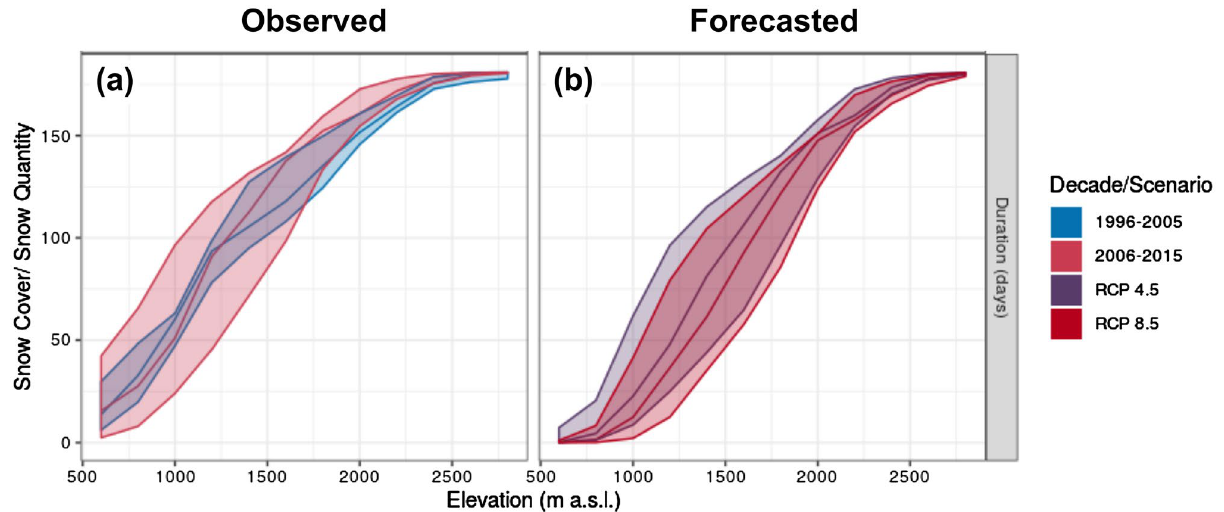
Figure 2. Snow cover duration for each winter season (Nov–Apr) as a function of altitude in the study area, calculated using GEOtop 2.0 (Supplementary S2). Central continuous lines denote the 50th percentile, while range between 25 and 75th percentiles is shown by the colored areas. RCP scenarios refer to the last decade of the projection period